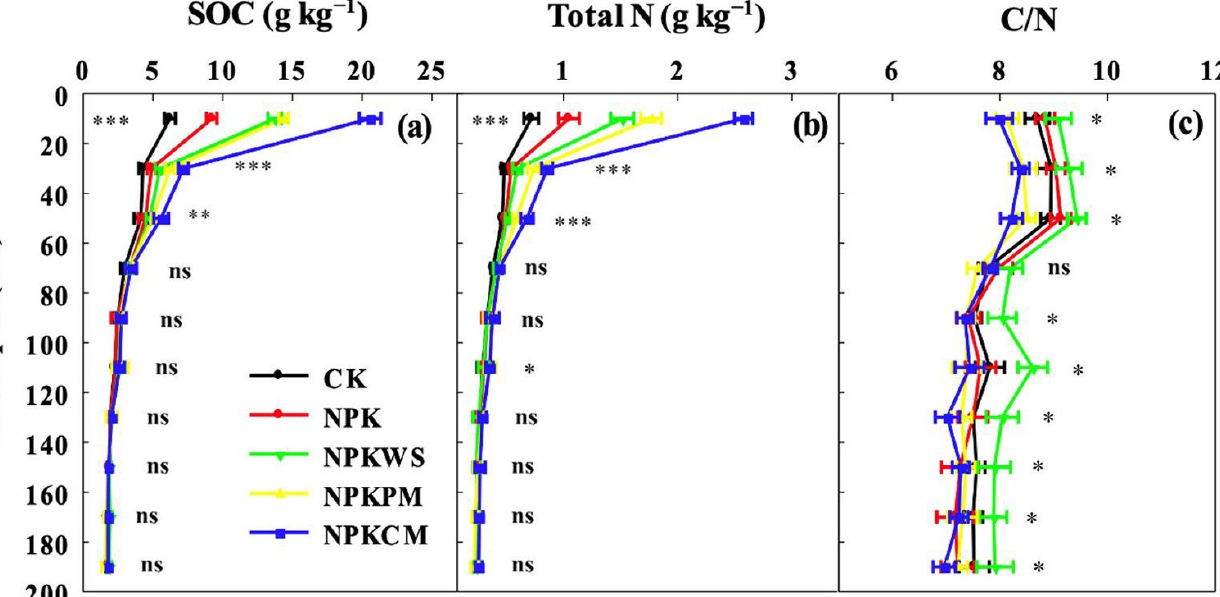
Figure 2. Soil organic carbon (SOC), total N contents and the C/N ratio in the 0–200 cm depth after 32 years of fertilization in Vertisols. ( a ) Soil organic carbon (SOC), ( b ) total N and ( c ) the C/N ratio. CK: no fertilization; NPK: chemical fertilizers; NPKWS: NPK plus wheat straw; NPKPM: NPK plus pig manure; NPKCM: NPK plus cattle manure. The asterisks indicate significant differences among planting systems within the same soil layer, * p < 0.05, ** p < 0.01, *** p < 0.001; ns: not significant.